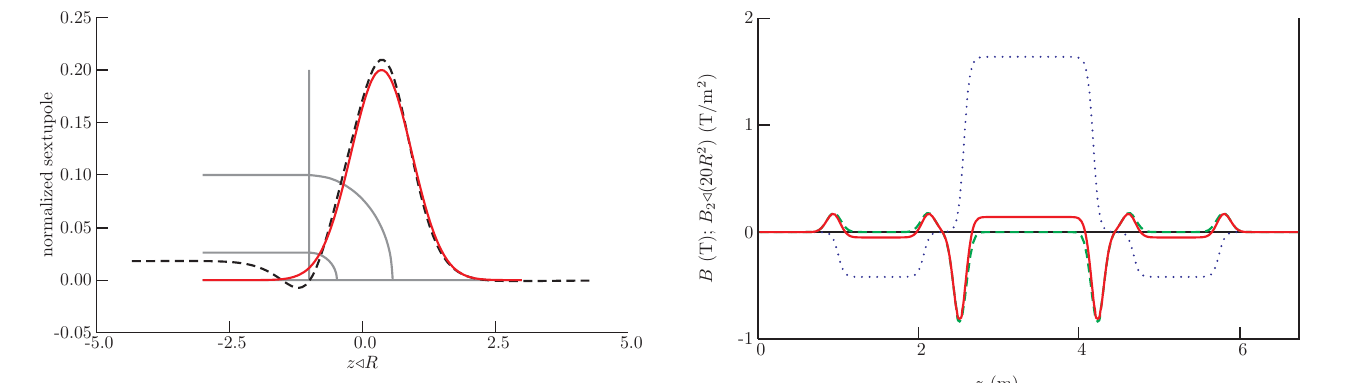
FIG. 34. (Color) Sextupole field components in the lattice used for tracking. The dotted line is the dipole field, the dashed line is = (cid:3) 20 R 2 (cid:4) with zero body sextupole field, and the solid line is B 2 with sufficient body sextupole field to eliminate the third-order resonance.